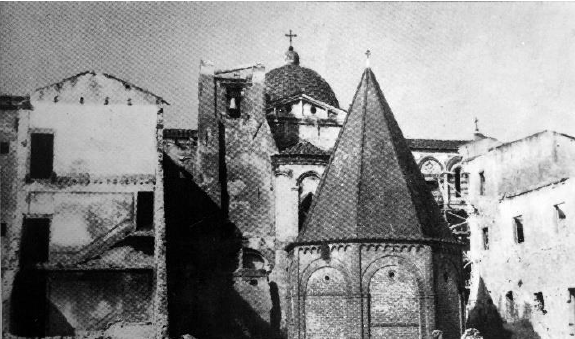
Figure 2. The chapel and the surrounding buildings during the bombing in 1943 (Nuti,